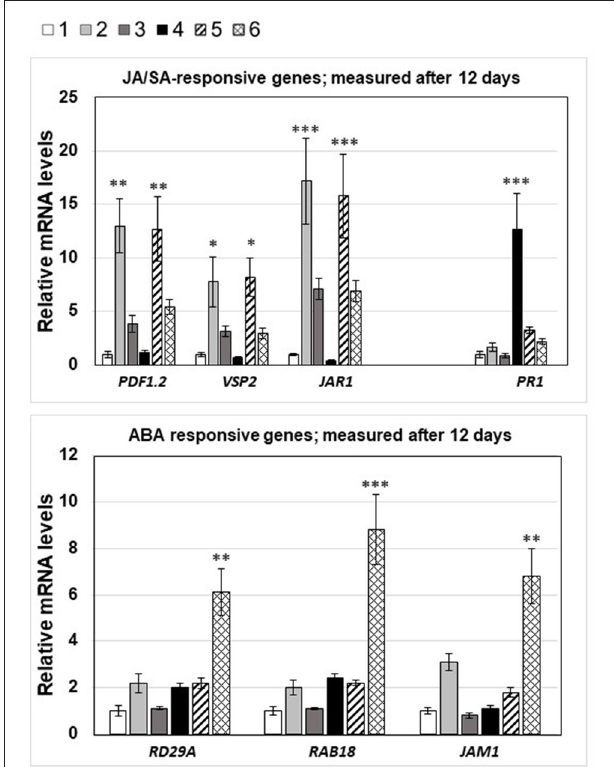
FIGURE 7 | mRNA levels of JA-, SA-, and ABA-responsive genes in the 6 seedlings shown in Figure 3A , 12 days after spore infection: 1, no treatment; 2, A. brassicae infected material; 3, seedlings grown next to A. brassicae -infected seedlings, 4–6, as 1–3, except that seedlings were connected by a P. indica hyphal network. The experimental conditions were the same as described in the legend to Figure 4 . Asterisks indicate significant differences of the values for Alternaria-treated tissue compared to the corresponding control (1, no treatment) at the same time point, as determined by Student’s t -test (* P ≤ 0.1; ** P ≤ 0.01; *** P ≤ 0.001).